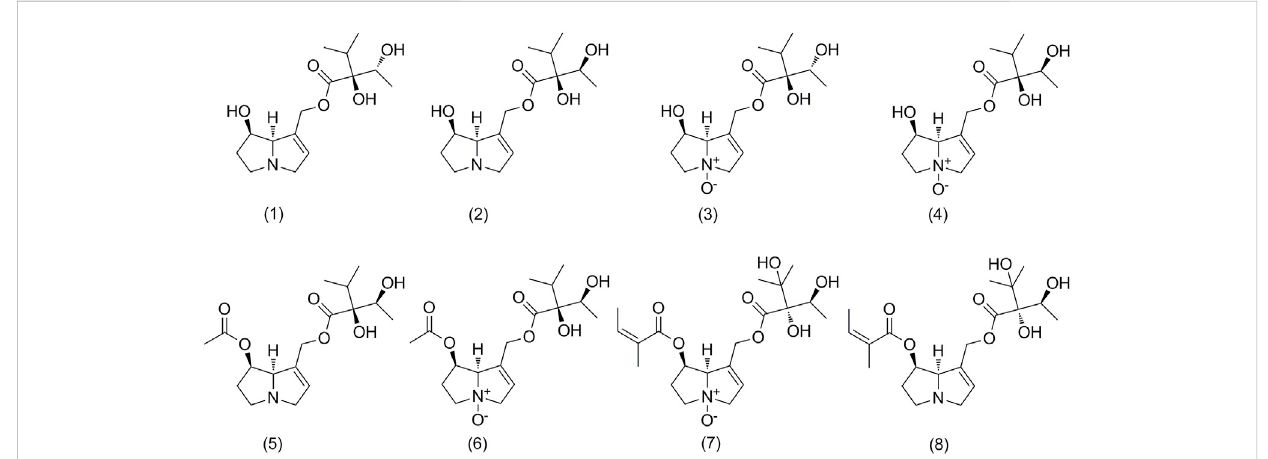
FIGURE 1 Chemical structures of pyrrolizidine alkaloids analyzed in Arnebia euchroma , A. guttata , and Lithospermum erythrorhizon . Intermedine (1), lycopsamine (2), intermedine N -oxide (3), lycopsamine N -oxide (4), 7-acetyllycopsamine (5), 7-acetyllycopsamine N -oxide (6), echimidine N -oxide (7), and echimidine